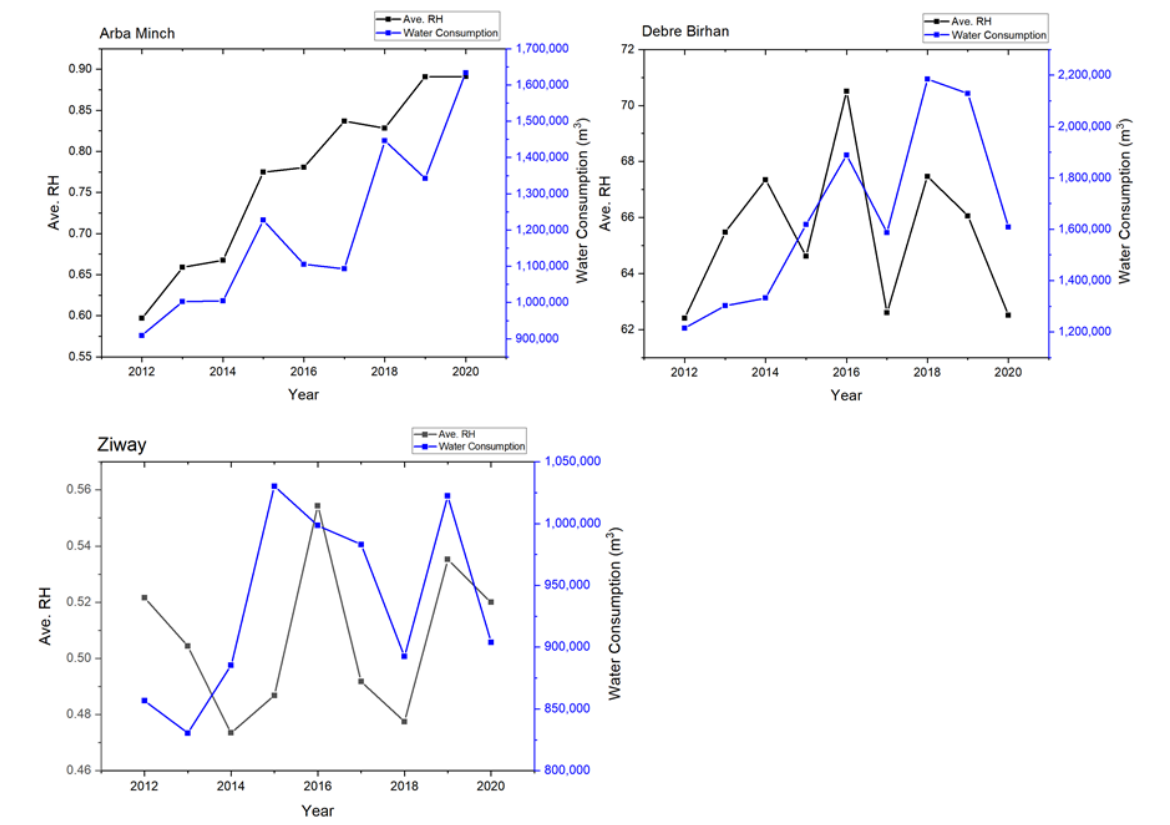
Figure 5. Average relative humidity vs. water consumption for the study areas .